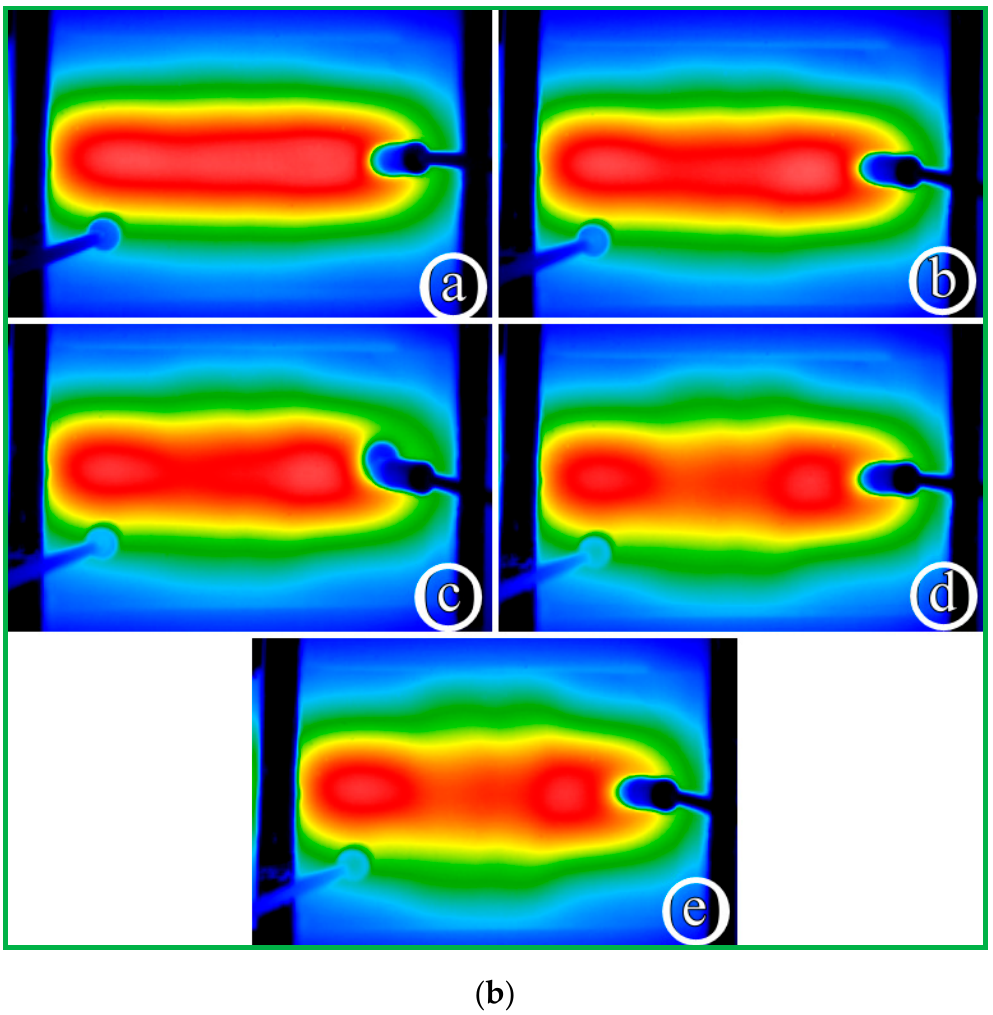
Figure 8. The temperature distributions of the chip surface ( a ) when the water flow rate is 1, 2, 3, 4, and 5 µ L/min, respectively, and ( b ) when the water flow rate is 10, 15, 20, 25, and 30 µ L/min, respectively. Secondly, the channel temperatures are measured using thermocouples inserted into the PDMS/glass bonding chip, placed in contact with the glass substrate, and connected to a data acquisition system (Model NI 9211, National Instruments, Austin, TX,